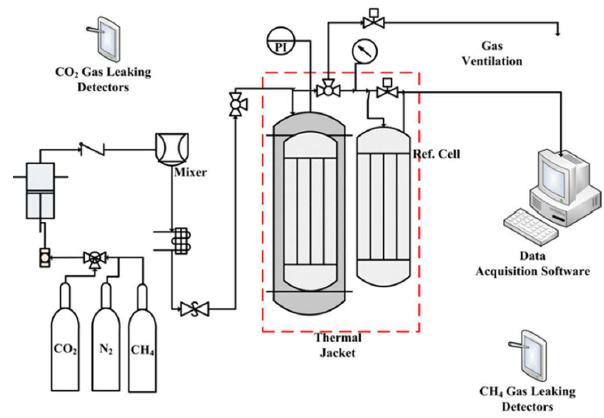
Figure 1. A schematic diagram of the volumetric sorption measurement